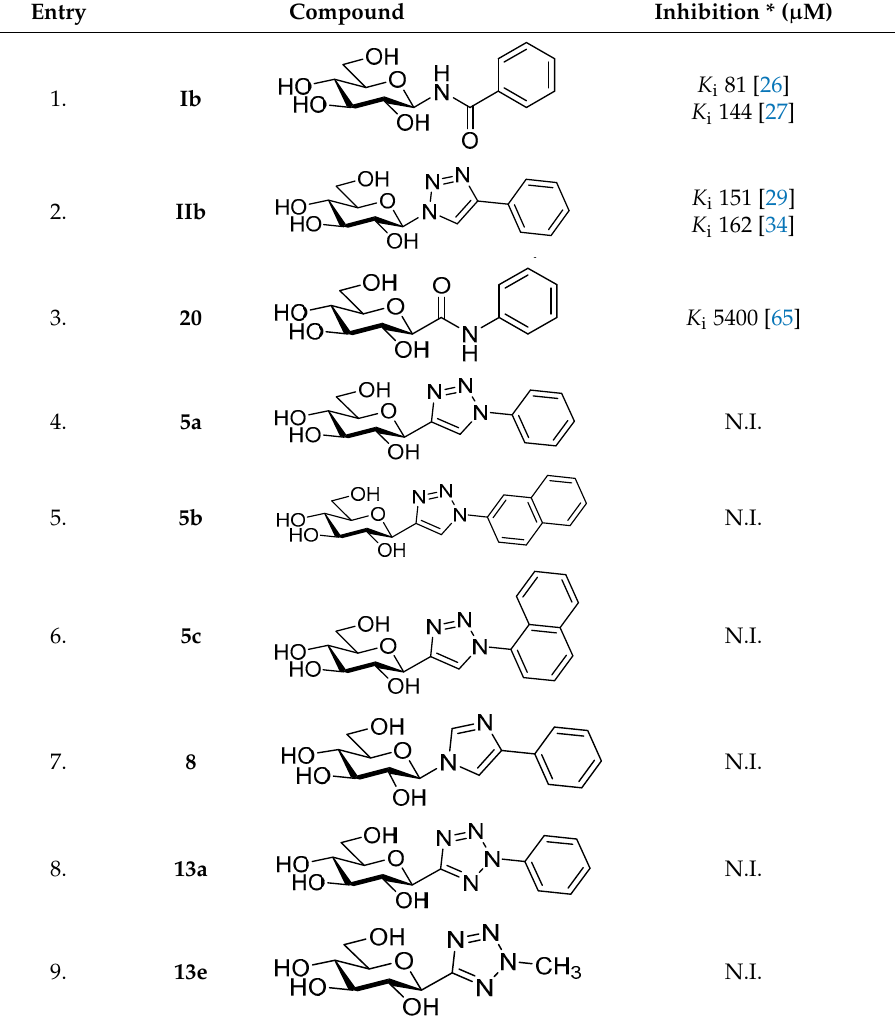
Table 5. Inhibitory effect of the new and some earlier compounds against rabbit muscle glycogen